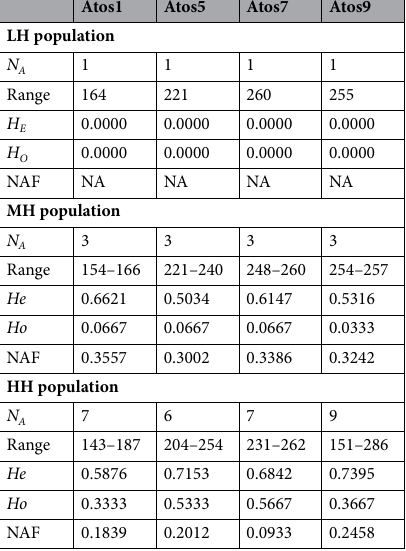
Table 1. Characteristics of the four microsatellite loci (Atos1, Atos5, Atos7, Atos9) including the number of alleles ( N A ), range of allele sizes (range, in bp), expected and observed heterozygosity ( H E , H O ) and null-allele frequency (NAF) for three experimental populations